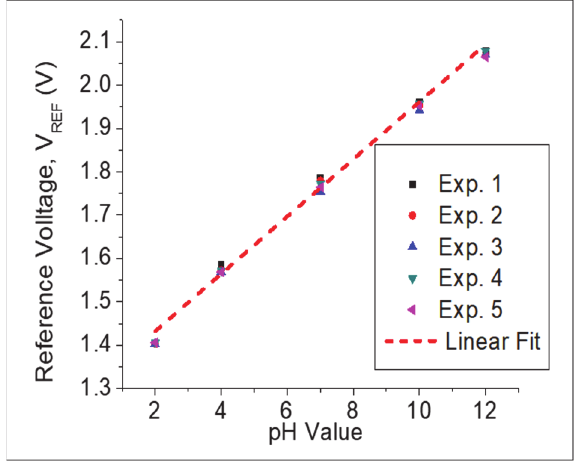
Figure 9. R epeatability curve of TiO 2 –PANI composite thin film. Figure 9. Repeatability curve of TiO